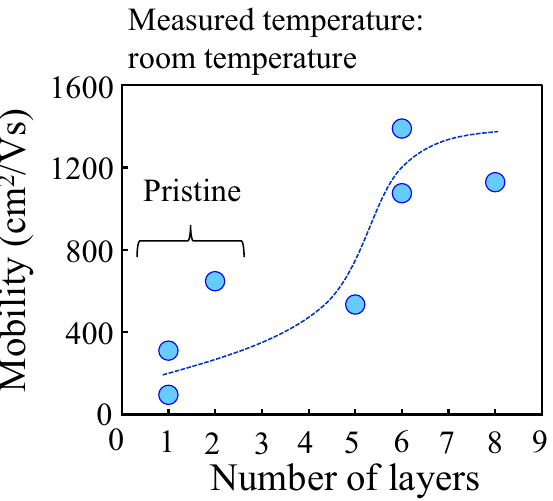
Figure 5. Field effect mobility vs the number of layers measured at room temperature. The monolayer and bilayer GNR is a pristine GNR. The dashed line is an eye guide.